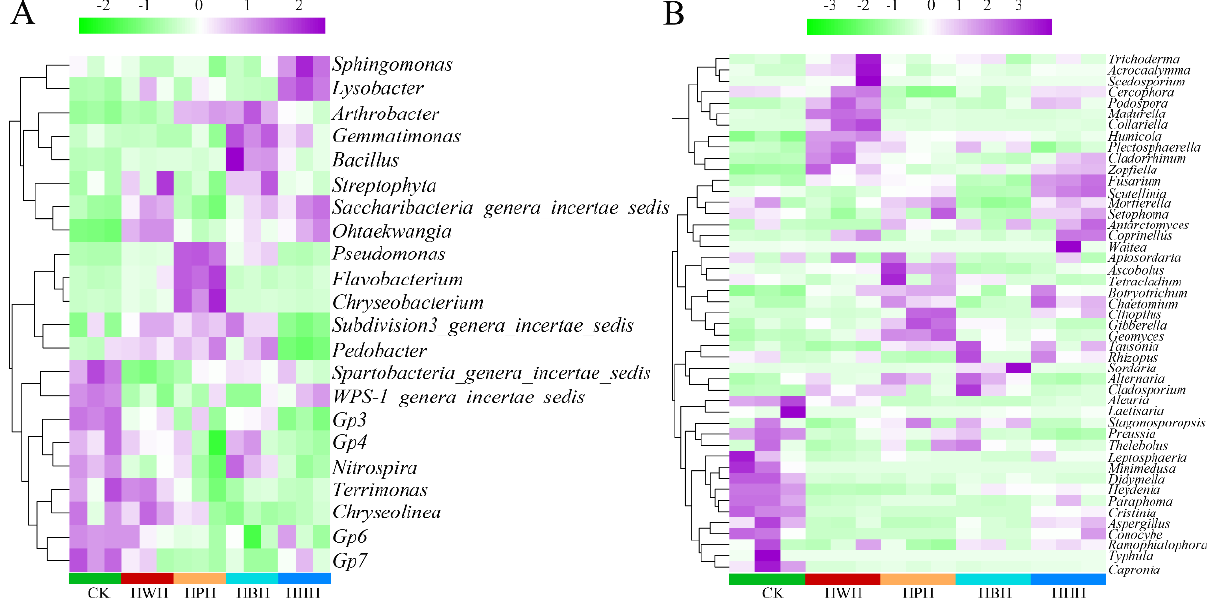
Figure 6. Heatmap of soil bacterial ( A ) and fungal ( B ) communities at the genus level under different culture conditions.